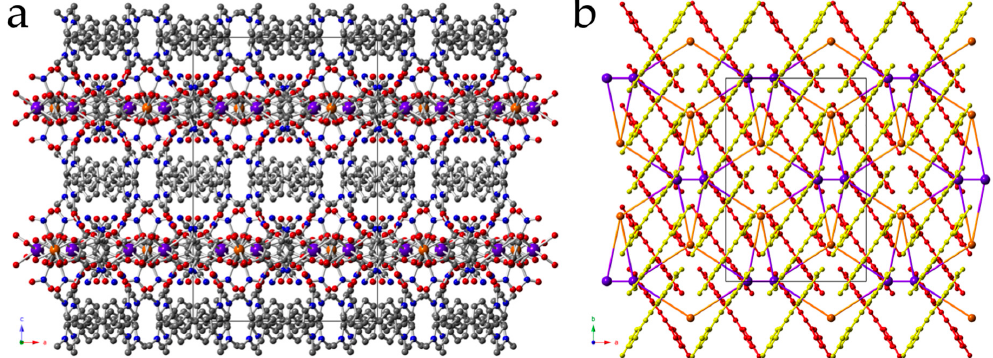
Figure 2. ( a ) View of the alternating cationic and anionic layers in compound 1 . H atoms have been omitted for clarity. ( b ) View along the c direction of two consecutive cationic layers showing the different orientation of the DAMS + molecules in each layer (yellow and red). The anionic intermediate layer is only represented by the Fe(III) and Na + ions (orange and purple, respectively).